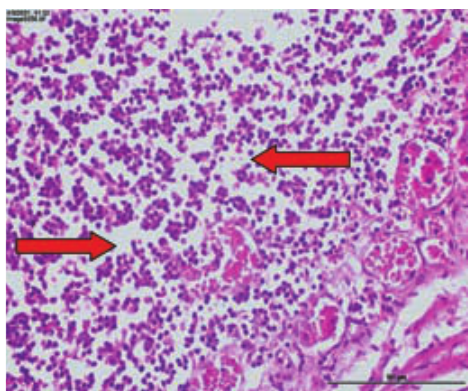
Fig. 5. Lymph node showing severe histiocytic infiltration (arrows) (H&E X 400)